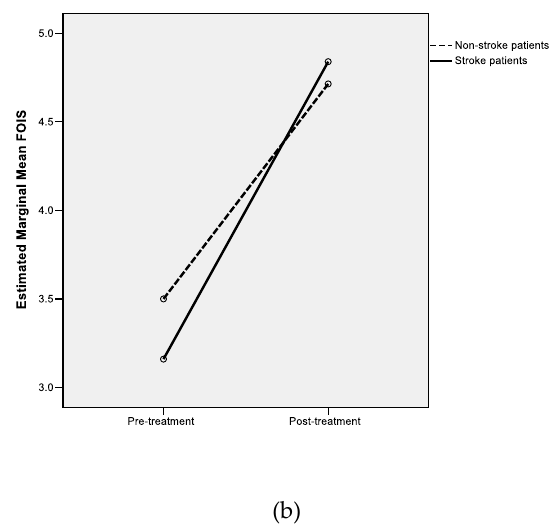
Figure 2. ( a ) Marginal means of FOIS for all stroke and non-stroke patients . ( b ) Marginal means of FOIS for stroke and non-stroke patients not exhibiting medical deterioration.